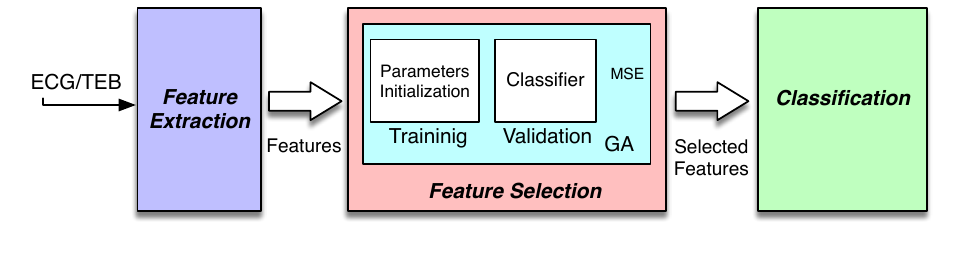
Figure 1. Complete system.